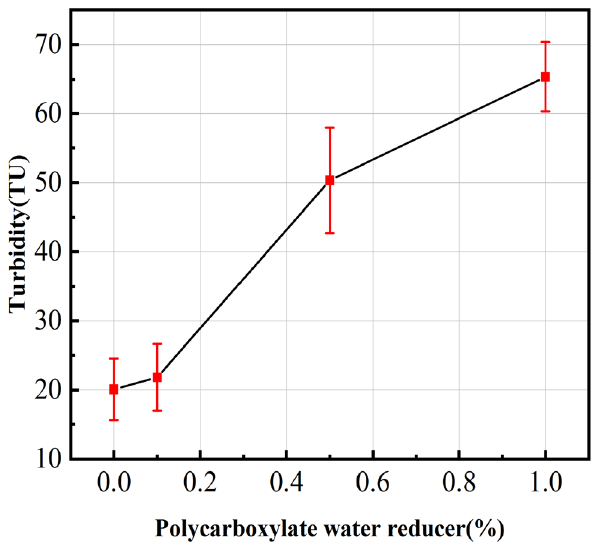
Figure 4. Relationship between turbidity and polycarboxylate water reducer.